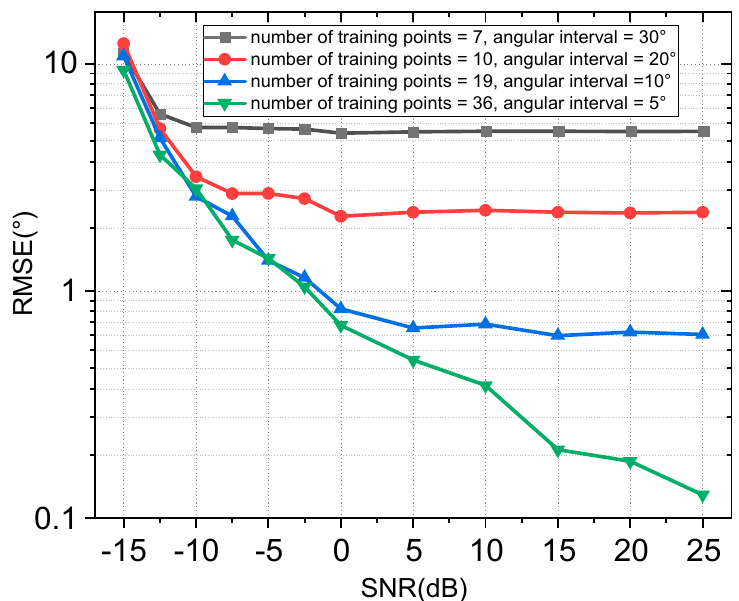
number of training points = 7, angular interval = 30° number of training points = 10, angular interval = 20° number of training points = 19, angular interval =10° number of training points = 36, angular interval = 5° Table 5. Training and test time of different methods. -